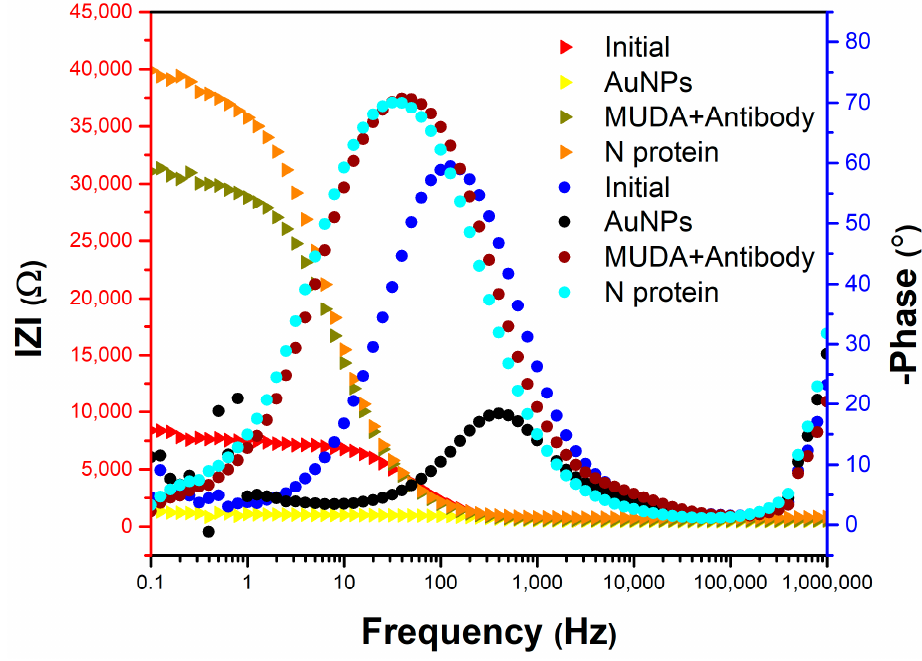
Figure 8. Bode diagram for the S6/02.08 sensor (WE area = 12.6 mm 2 ) with measurements after AuNP decoration, MUDA functionalization + antibody immobilization (one step), and N-protein binding.